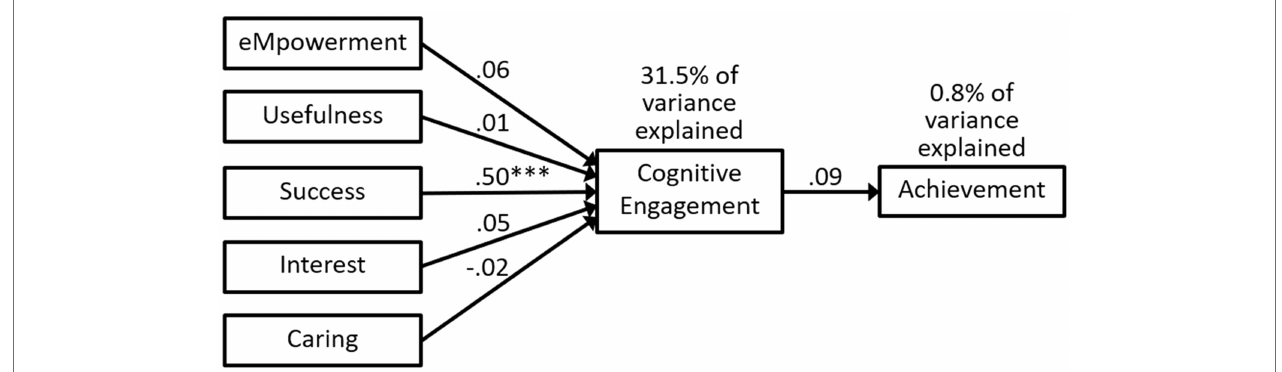
FIGURE 4 | Model 2a: path analysis predicting cognitive engagement and achievement. Statistics are standardized beta coefficients. *** p <